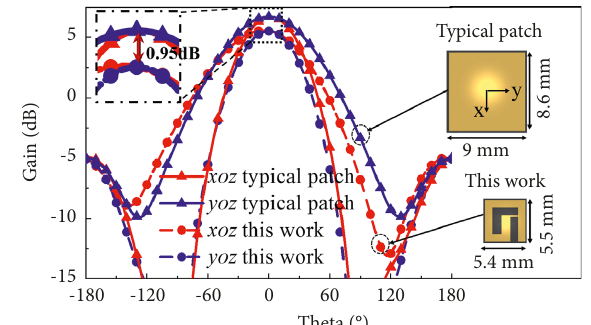
Figure 6: Simulated gain of the designed antenna and the typical patch.